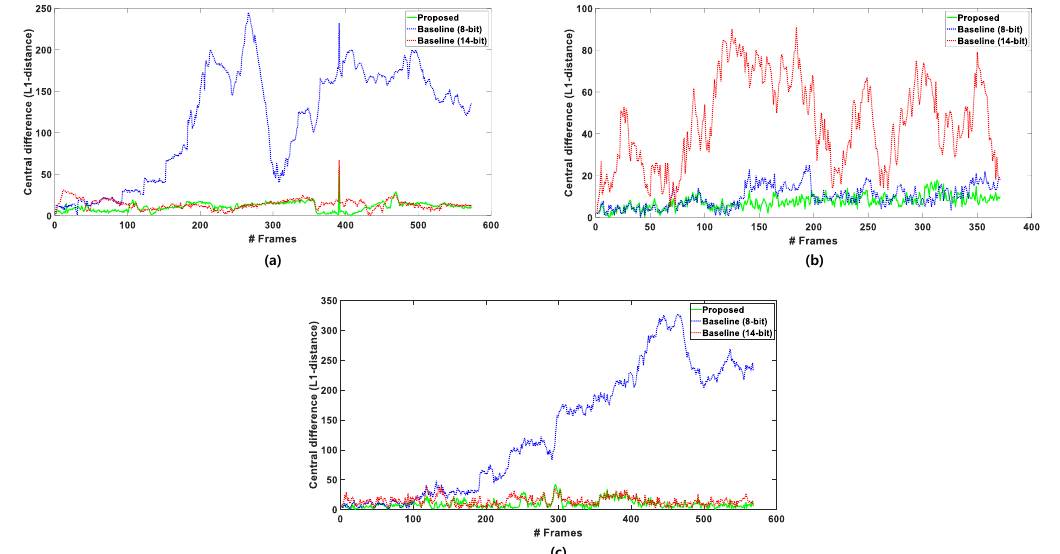
Figure 12. Central difference of each video sequence: ( a ) central difference (Figure 11a), ( b ) central difference (Figure 11b), ( c ) central difference (Figure